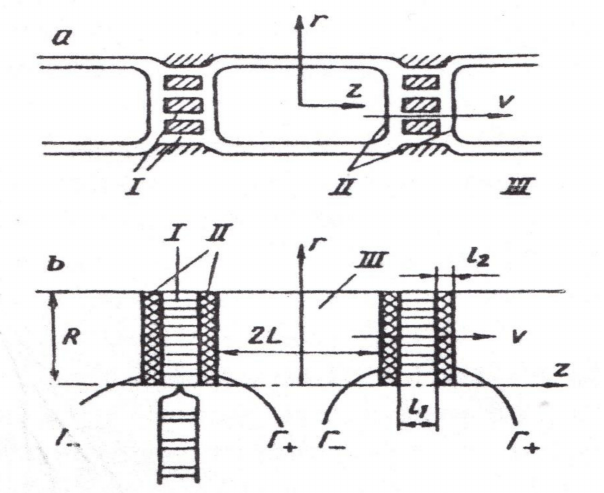
Figure 10. Schematic representation of the cell chain divided into zones: I—plasmodesmata; II— tonoplast; III—vacuole